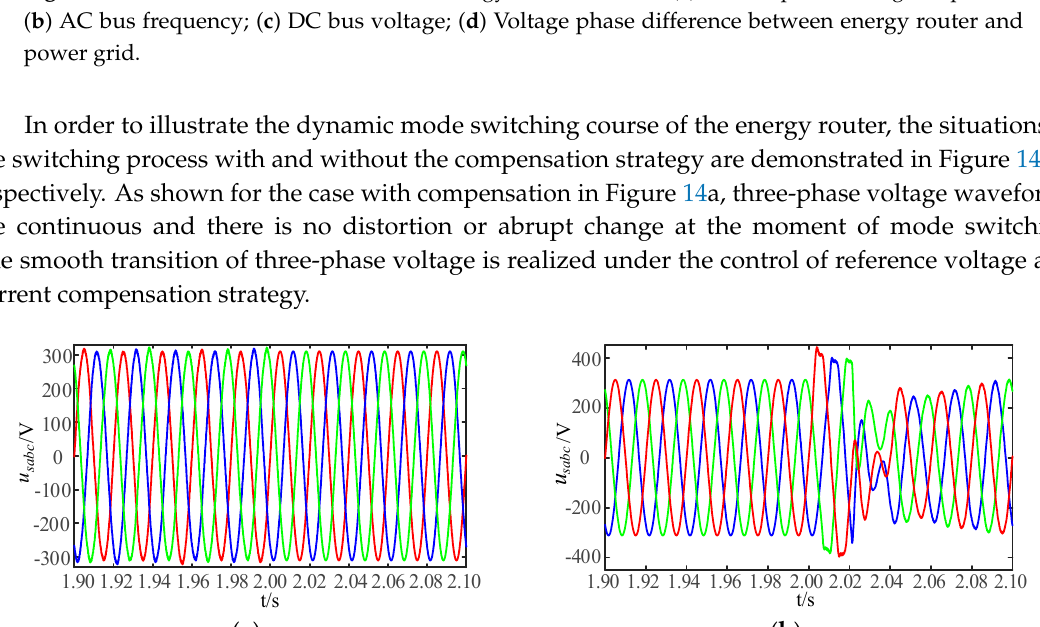
amplitude; ( b ) AC bus frequency; ( c ) DC bus voltage; ( d ) Voltage phase difference between energy router and